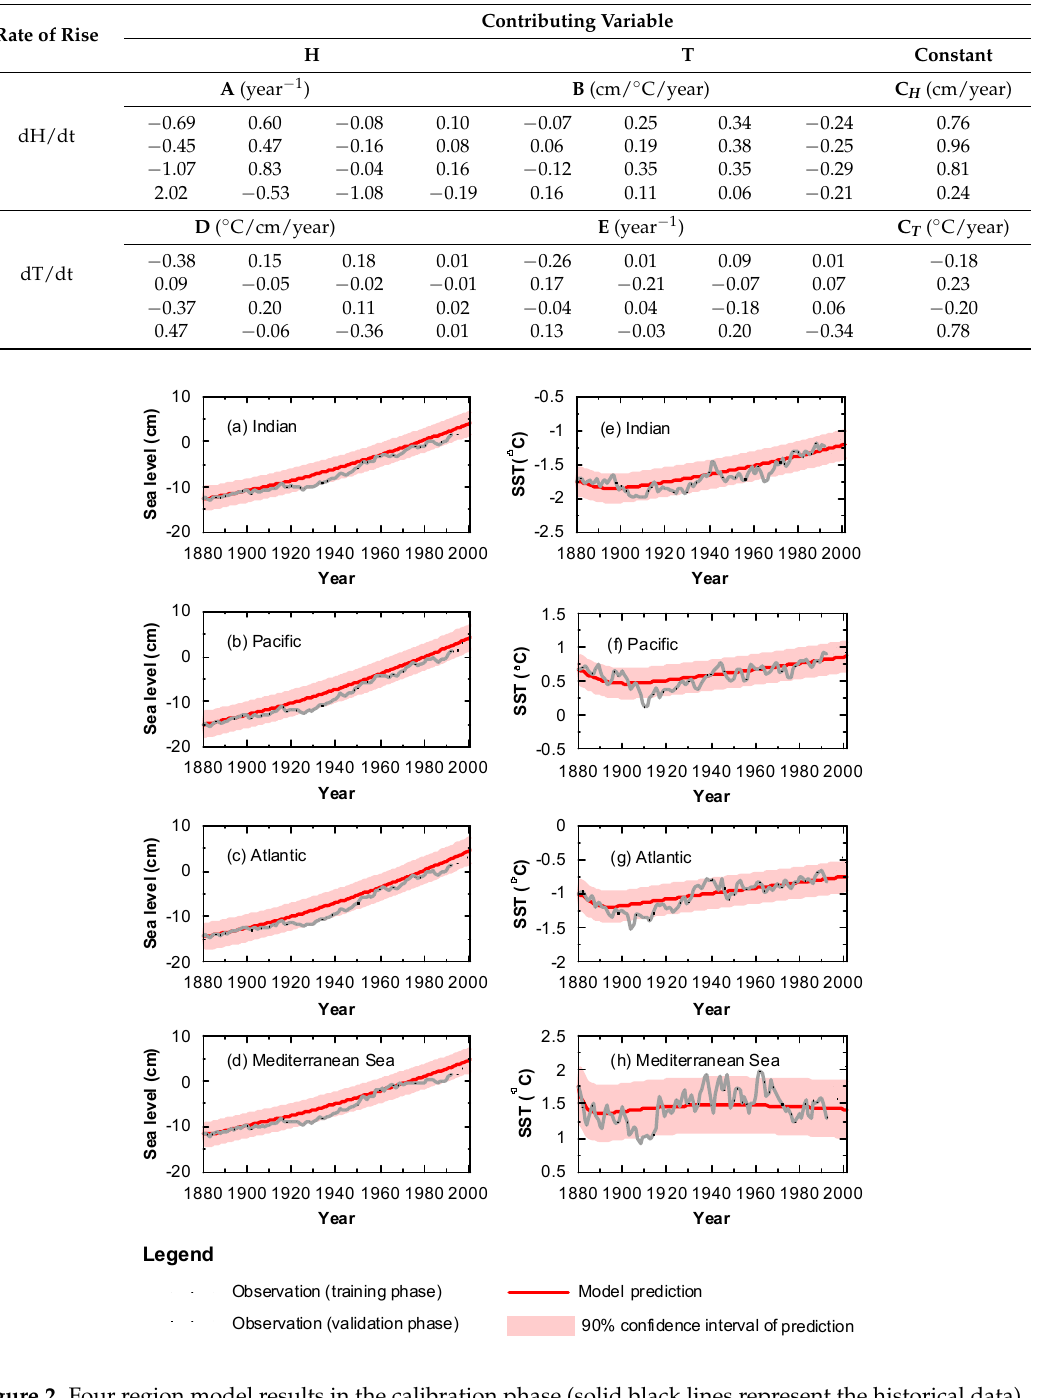
Figure 2. Four region model results in the calibration phase (solid black lines represent the historical data).